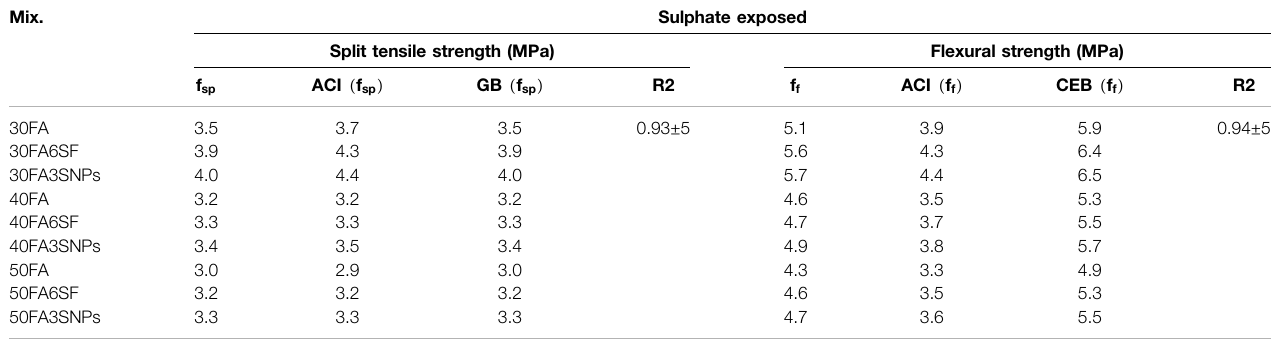
TABLE4| Thesplittensileand fl exuralstrengthofsulphateexposed30%,40%,and50% fl yashcontaining3%SNPsand6%SFincorporatedconcretesamplescompared with standard model strength after 365 days exposure. Mix.